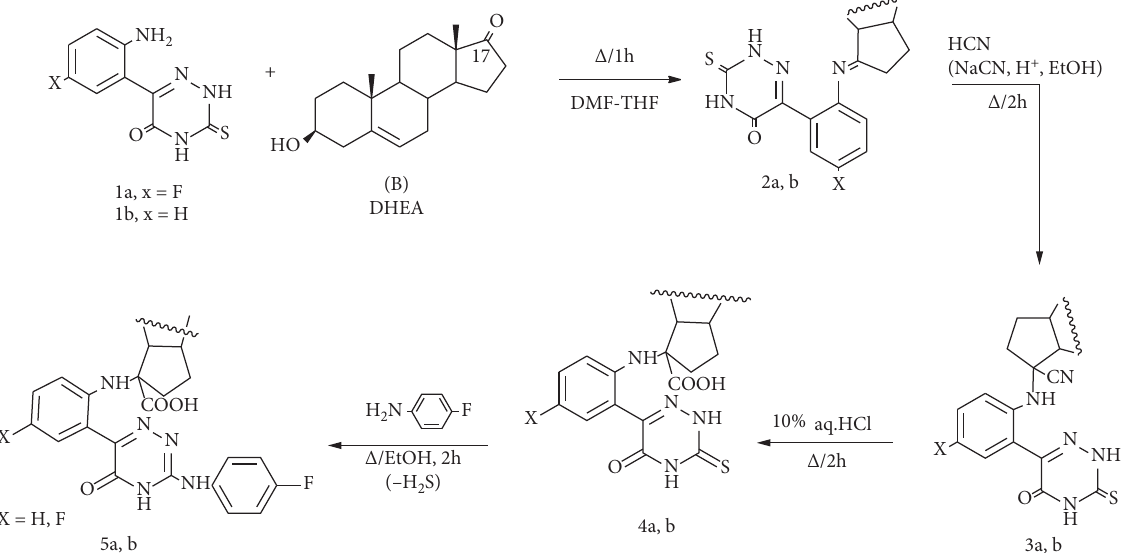
Scheme 1: Condensation of fluorinated/nonfluorinated 1,2,4-triazinones as 6-(2 ′ -amino-5 ′ -fluorophenyl)-3-thioxo-1,2,4-triazin-5(2H,